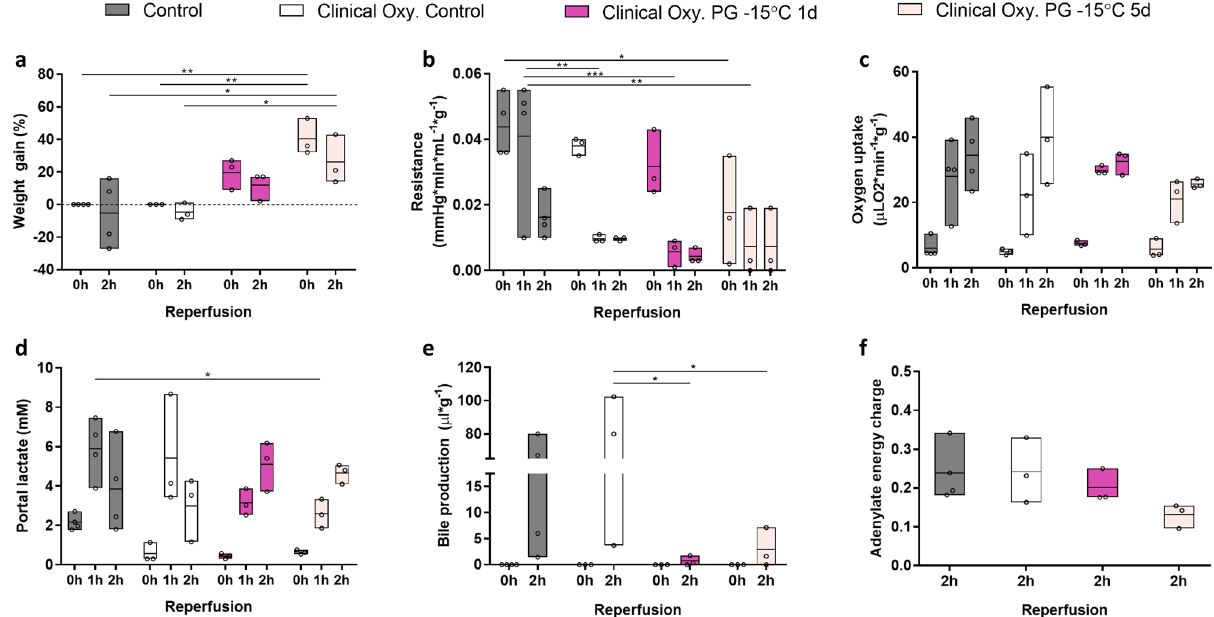
Fig. 4 Effect of a clinical grade oxygenator on the recovery of liver function after partial freezing with propylene glycol at − 15 °C for 1 and 5 days. a Weight gain as percentage of the procurement weight. b Vascular resistance between the portal vein and the IVC. c Oxygen uptake. d Lactate concentration in the portal vein. e Bile production. f Tissue adenylate energy charge. Control (gray) = 1 day hypothermic preservation, Clinical Oxy. Control (white) = 1 day hypothermic preservation perfused using a clinical grade oxygenator, PG = propylene glycol stored for 1 day at − 15 °C (dark pink) or 5 days at − 15 °C (light pink) perfused using a clinical grade oxygenator. Stars denote statistical signi fi cance (two-way ANOVA, followed by Tukey ’ s post-hoc test): *0.01 < p < 0.05; **0.001 < p < 0.01; ***0.0001 < p < 0.001; **** p < 0.0001. Boxes: Floating bars (min to max), with a line at the mean. Source data are provided as a Source Data fi